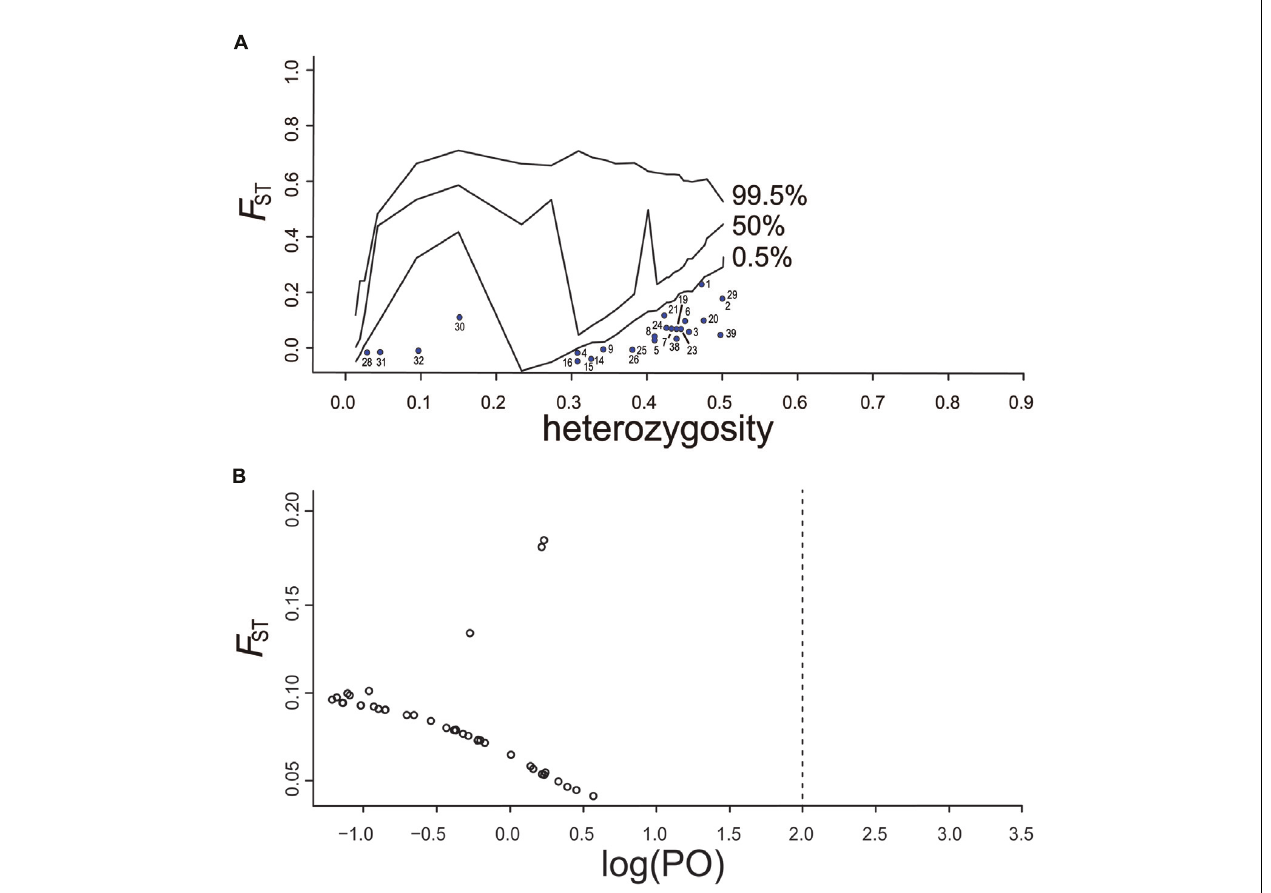
FIGURE 5 | (A) Results of outlier detection from the simulation with Dfdist. Plots of F ST value were against heterozygosity based on chloroplast SSR loci. The 0.5, 50, and 99.5% confidence intervals were corresponding to the lower, intermediate, and higher lines, respectively. No outlier locus under selection above the 99.5% line was detected in chloroplast genome. (B) Results of outlier loci from chloroplast SSR genomic scan by Bayescan. The vertical line showed the log 10 of the posterior odds (PO), which provides evidence whether the locus is subject to selection or not. No outlier locus under selection in chloroplast genome was detected at the decisive threshold value (log 10 PO =